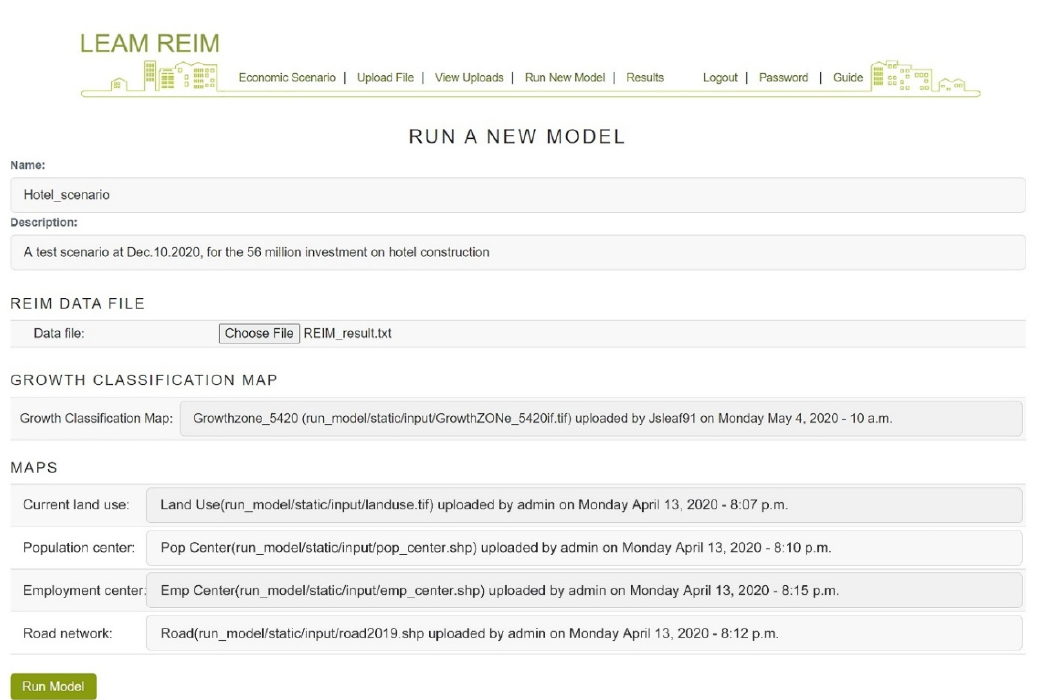
Figure 3. LEAM-REIM interface for uploading files. Users click “choose file” button to choose file from local portals to upload the model input files. A file name and description are required as notes for future use.